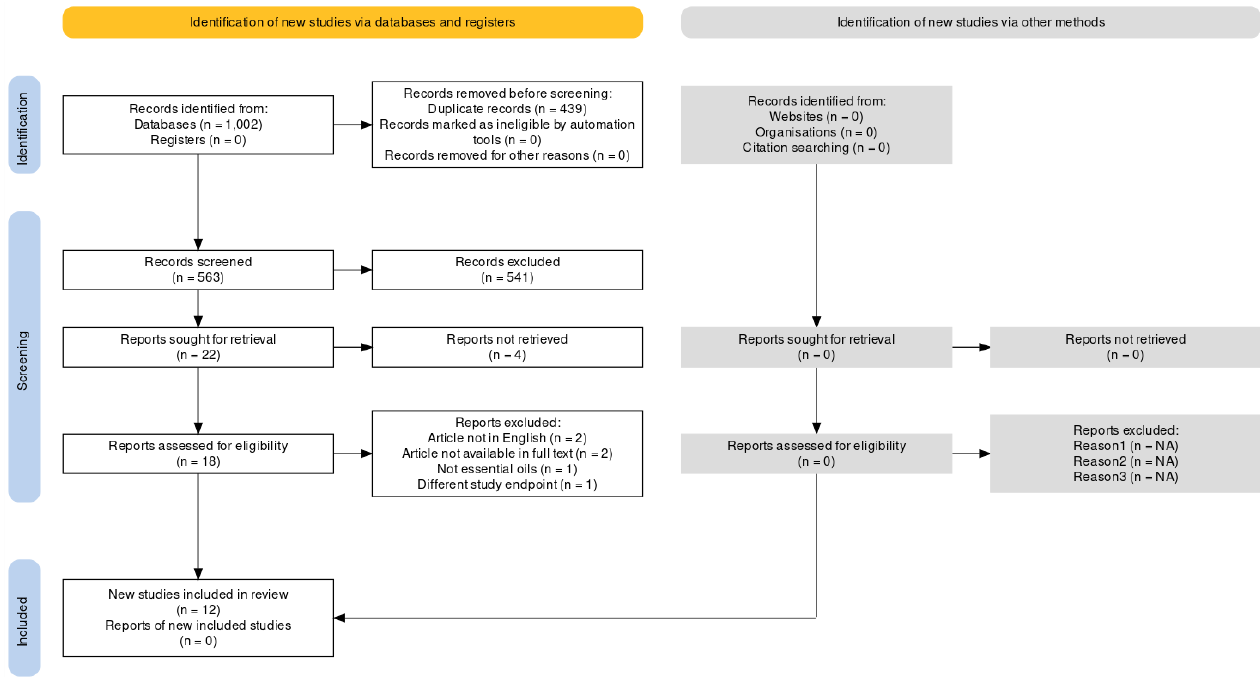
Figure 1. Process of extraction of results according to the Preferred Reporting Items for Systematic Reviews and Meta-Analyses (PRISMA) 2020 flow diagram produced with the web-based Shiny app [70].